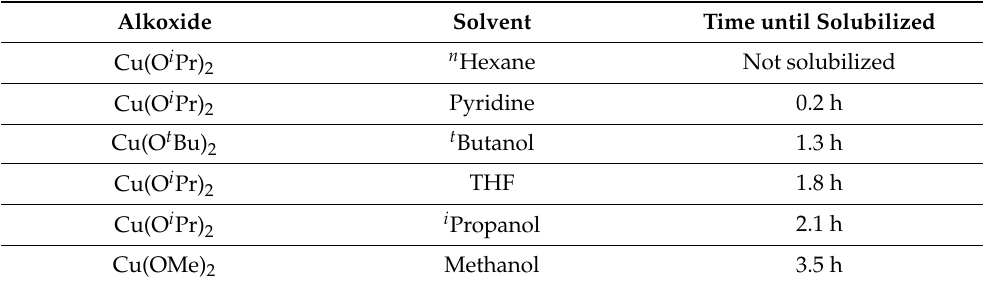
Table 3. CO 2 inserted alkoxides, n [M(OR) 2 ] = 3 mmol, V[CO 2 ] = 0.25 L ∙ min − 1 and n [solvent] = 300 mmol, T = 313 K.